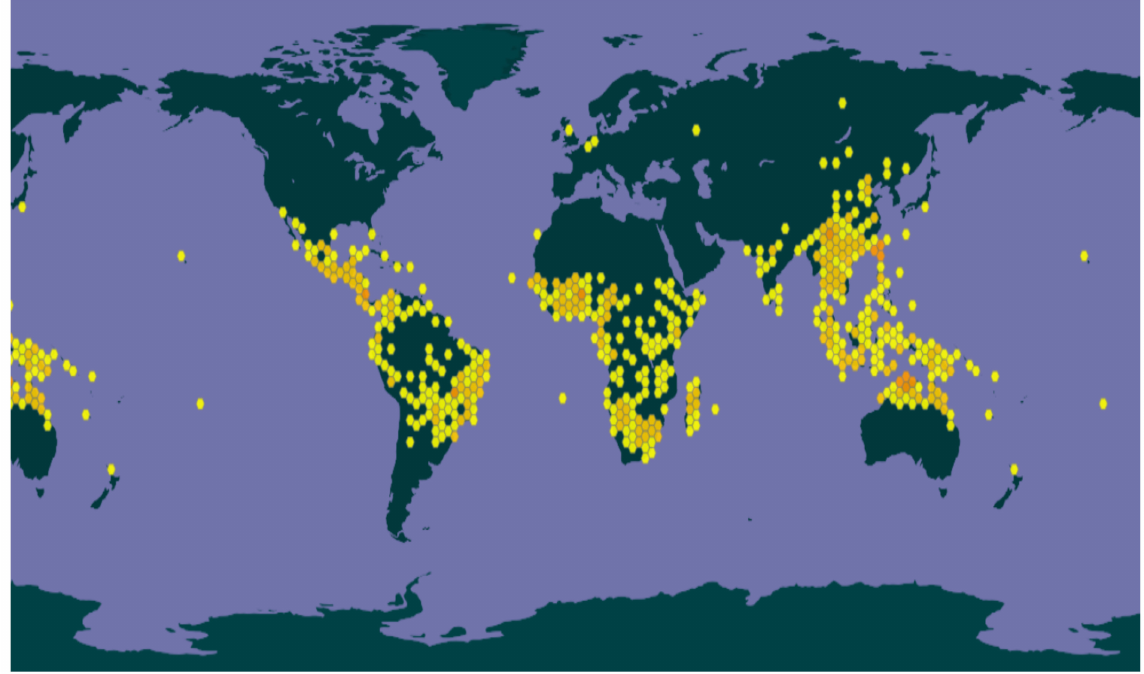
Figure 3. Global distribution of Merremia species (Image © OpenStreetMap contributors, GBIF, © OpenMapTiles)